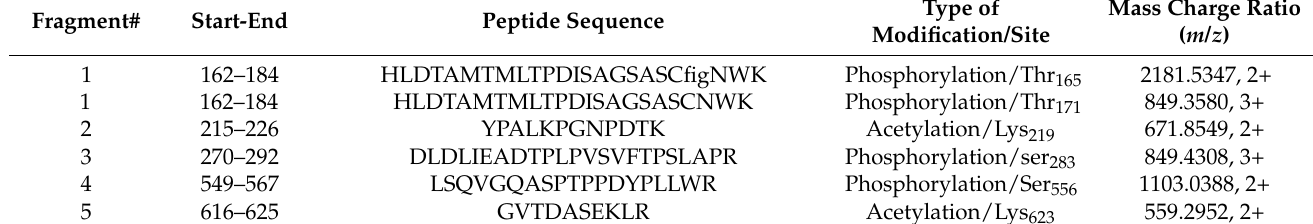
Table 1. Identification of Peptide Fragments with Phosphorylated and Acetylated Modifications in GCRV-VP5.